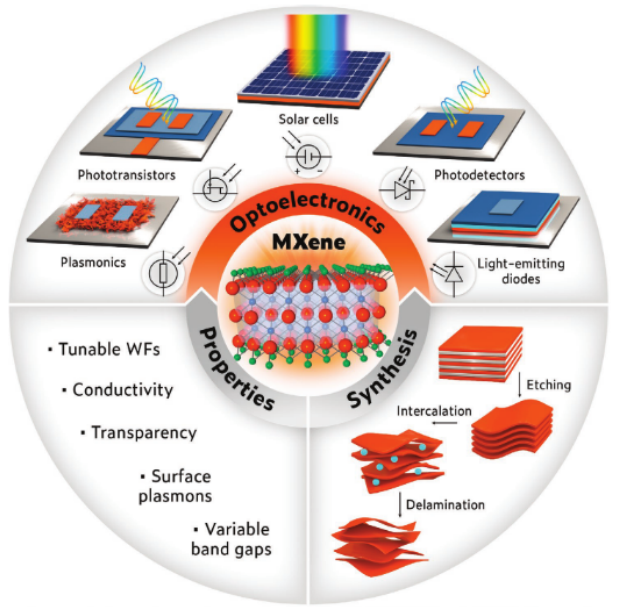
Figure 1. MXene synthesis, properties, and their applications. Reprinted with permission from ref. [73]. Copyright 2021 John Wiley & Sons, Inc.